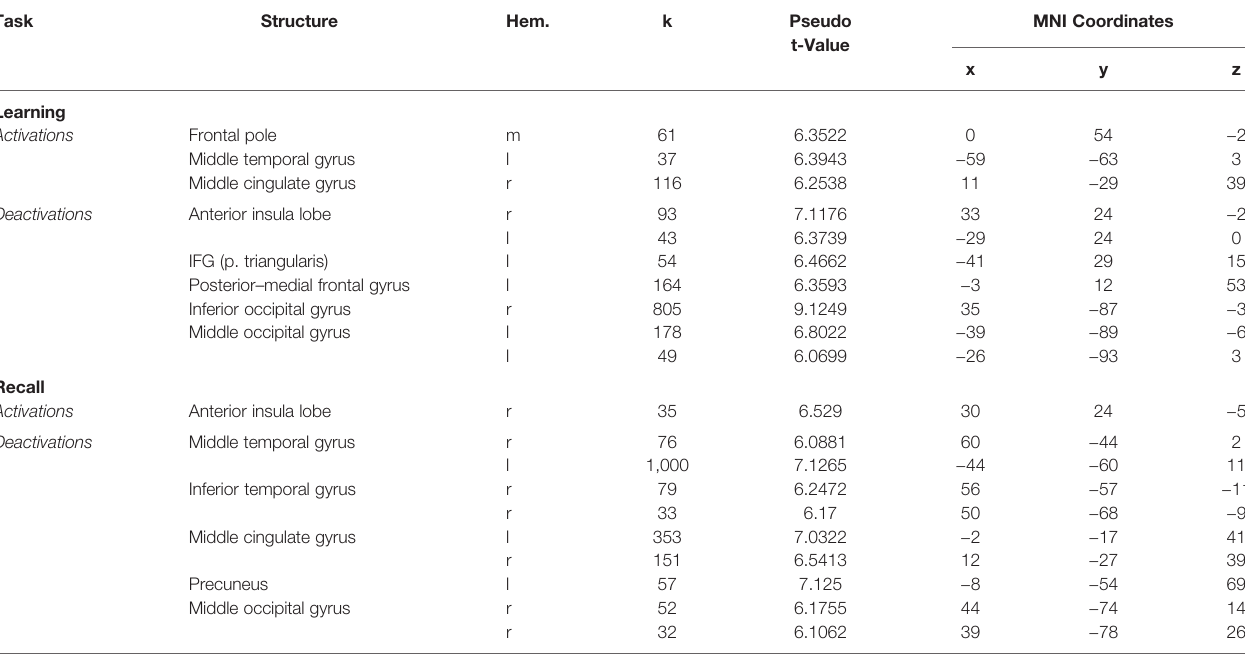
TABLE 1 | Signi fi cant neural activations and deactivations during mnemonic encoding and recall. Task